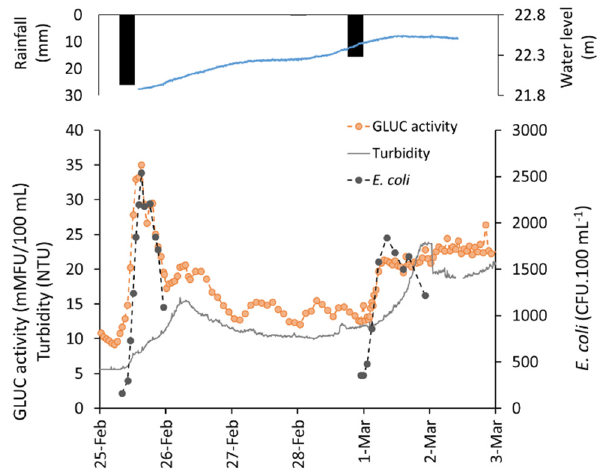
Figure 1. Enumeration of culturable E. coli (black dots) along the GLUC activity (orange dots) pollutograph using the synchronous triggering mode at site 1. Two microbiological peak events were observed following rainfall episodes. During the synchronous mode, raw water samples were collected by an ISCO6712 autosampler triggered by hourly autonomous GLUC activity measurements in raw water. Turbidity (grey line) was measured online at the drinking water treatment plant intake. Rainfall (black histograms) and water level (blue line) are indicated at the top of the chart.